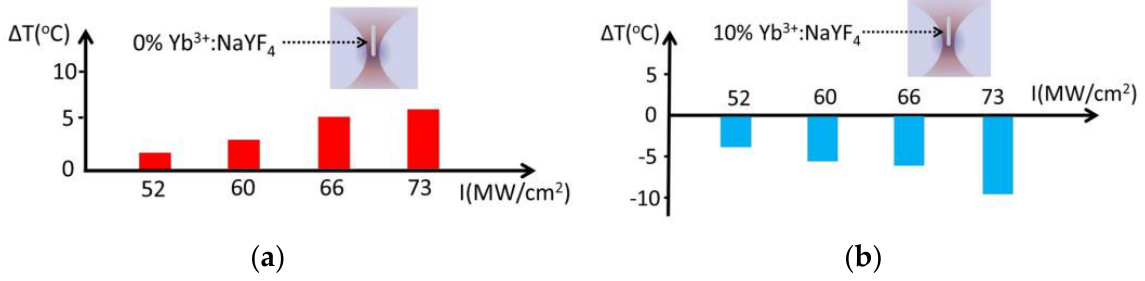
At an irradiance of 73 MWcm − 2 , nanowires were observed to refrigerate by > 9 ◦ C below ambient temperature (Figure 9b).